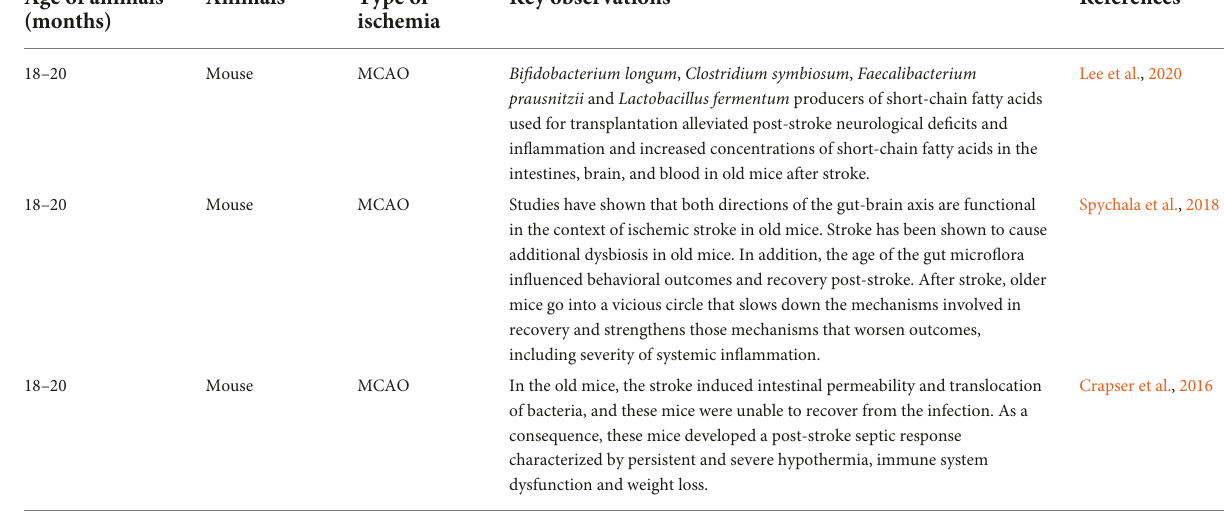
TABLE 2 Experimental studies on the role of aging gut microflora in